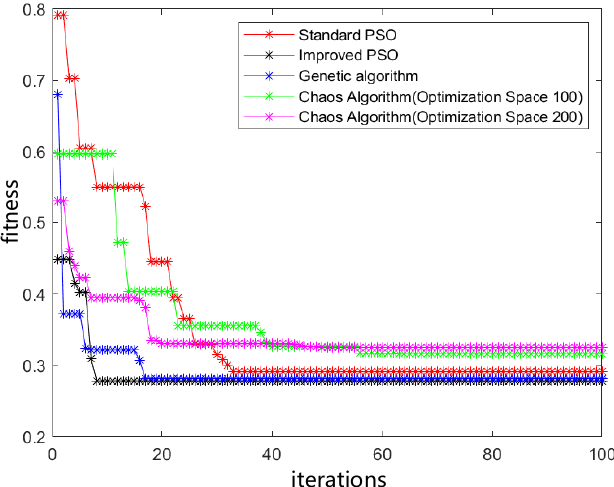
Figure 12. Comparison of iterative process before and after PSO algorithm improvement. The running time of each joint in section AB optimized by the improved PSO algorithm is shown in Table 5. Table 5. Time before and after the optimization of section AB.